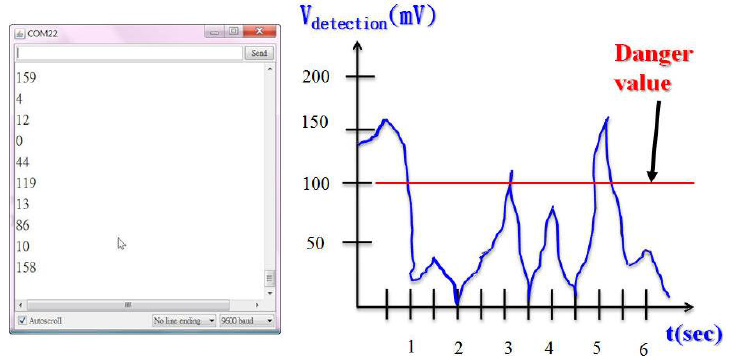
Figure 16. Actual measurement of the vibration